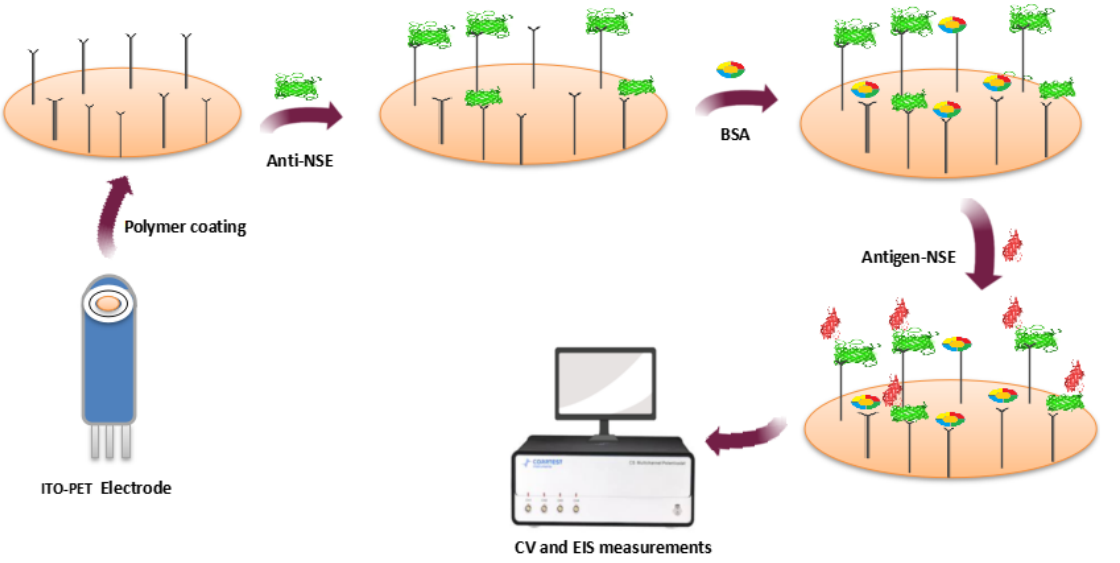
Figure 4. Immunosensor for NSE determination . Table 1. Electrochemical biosensing platforms to detect cancer